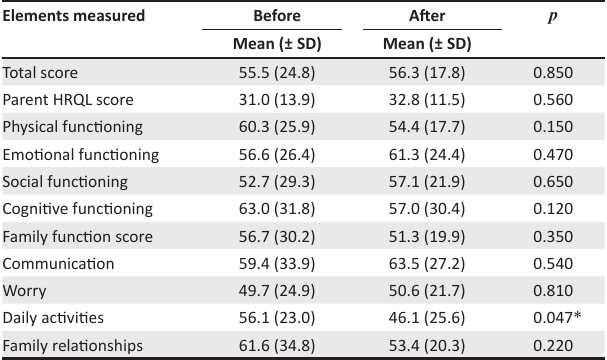
TABLE 4: Paediatric quality of life-family impact module results ( n = 16). Elements measured Before After